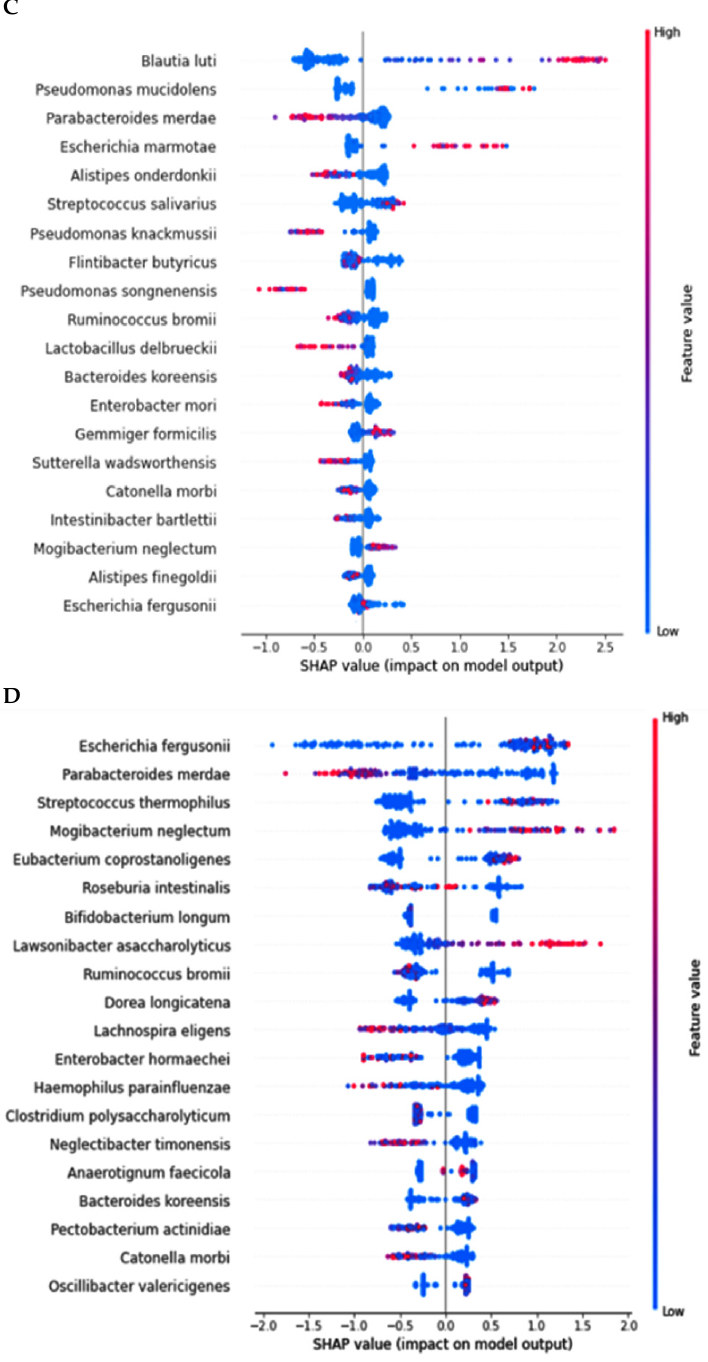
Figure 3. Primary bacteria selected at the genus level by the LDA and the species level by XGboost, according to the healthy, MCI, and AD groups in the participants with enterotype Bacteroides. ( A ) Linear discriminant analysis (LDA) scores of the bacteria at the genus level. ( B ) Relative abundance of bacteria at the species level, according to the healthy, MCI, and AD groups. ( C ) The predicting model for bacteria at the species level in the comparison between the healthy and MCI groups (AUC of ROC = 0.935, 10-fold crossover for trained and test sets = 0.78 ± 0.02 and 0.85 ± 0.03, respectively). ( D ) The predicting model for bacteria at the species level in the comparison between the healthy and AD groups (AUC of ROC = 0.947, 10-fold crossover for trained and test sets = 0.77 ± 0.03 and 0.81 ± 0.03,